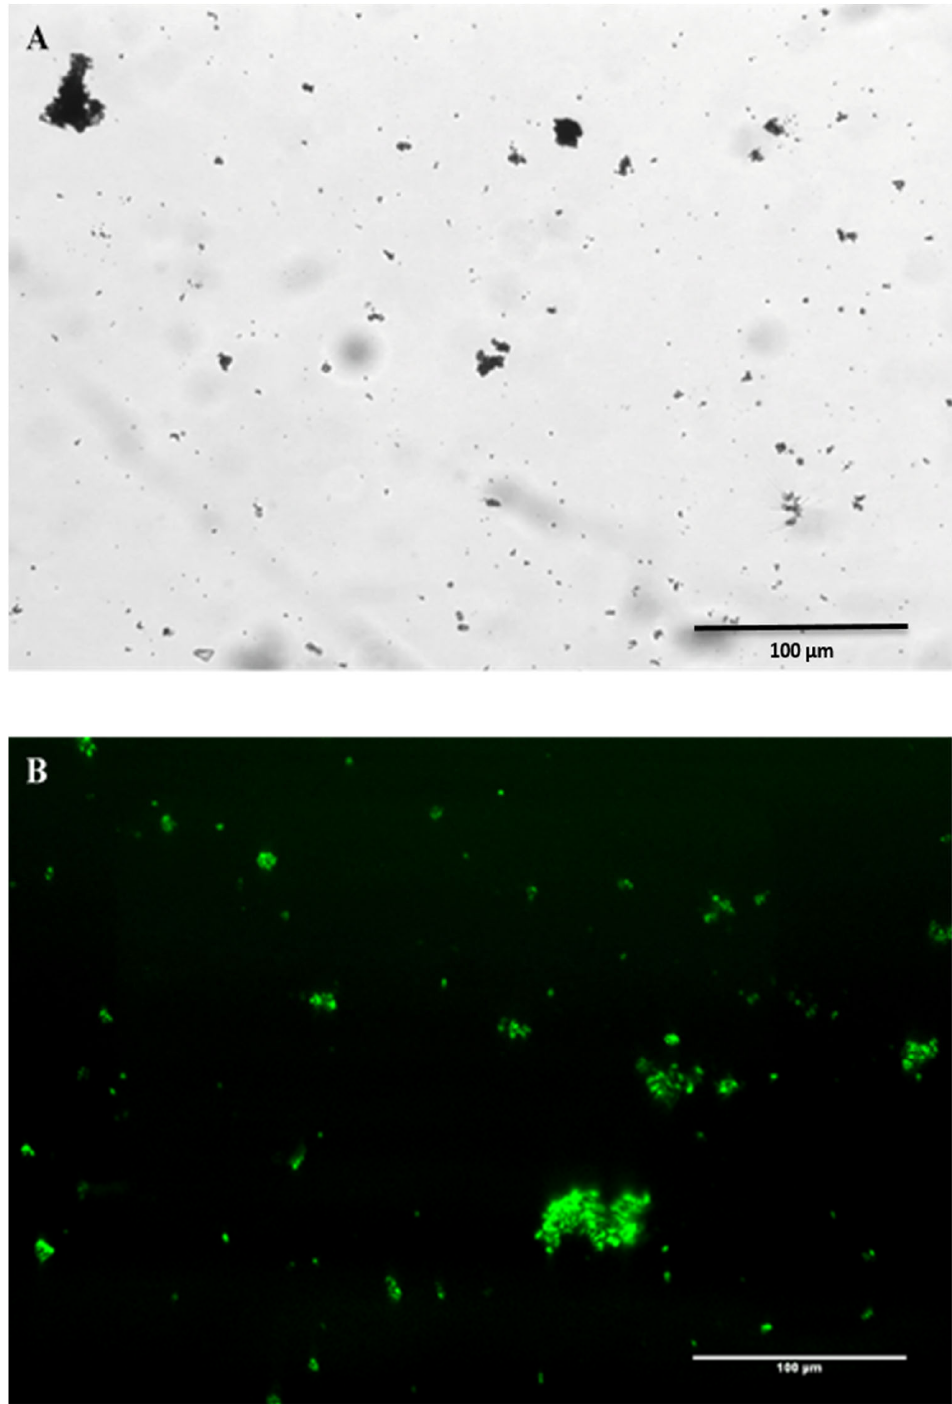
Coomassie blue (( C , D ); yellow arrows). Scale bar = 40 µm. Images captured using upright Leica microscope and fi bre light with 10× objective.